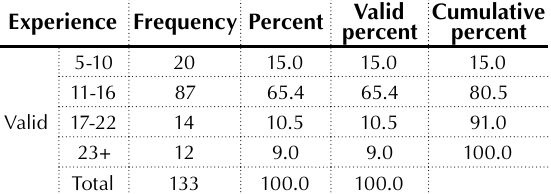
Table 3. Frequency and percentage of sample characteristics according to experience